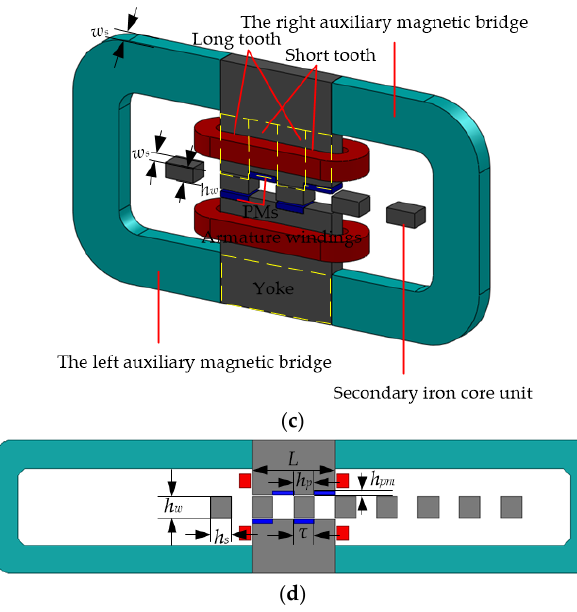
Figure 7. The equivalent model of the unit machine: ( a ) The axial diagram of unit machine; ( b ) The circumferential stretching model; ( c ) Equivalent 3D model; ( d ) The model of equivalent 2D finite element method (FEM). Table 1. The design parameters of unit machine and model of equivalent 2D FEM.